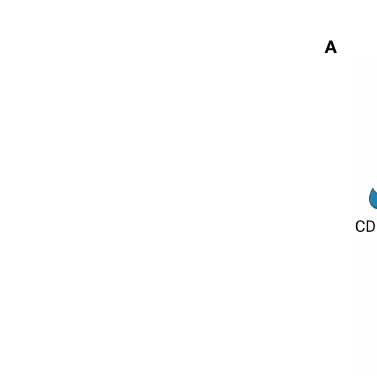
FIGURE 1 | Comparing and contrasting tissue resident memory and effector memory T cell phenotypes in skin. (A) Tissue resident memory (TRM, left, blue) cells downregulate S1P1 and CCR7, which are used for recirculation in the blood and lymph, when they take up residency in skin. TRMs use CD69, which was previously thought to be a marker of recently activated T cells, to block the expression of S1P1 on the cell surface and prevent exit from the tissue. CD103 is an integrin family member that is involved in skin and mucosal homing. It is not required for skin retention, but is expressed at a much higher rate in TRM cells in the epidermis compared to T cells in the dermis. CD49a has recently been used to distinguish the CD8+CD103+CD49a+ TRM T cells involved in mediating disease in vitiligo from the CD8+CD103+CD49a- TRM cells involved in psoriasis. TRM cells survive long-term in the nutrient-poor conditions of the skin by metabolizing free fatty acids. Increased expression of FABP4 and FABP5, fatty-acid binding proteins, allows TRM cells to take up larger amounts of exogenous free fatty acids for energy. IL-15 is required for TRM differentiation in skin, and TRM bear the CD122 and CD132 receptor chains. Keratinocytes can present IL-15 to TRM in trans on the CD215 receptor chain. TRM cells increase expression of PD1, which has a known inhibitory role in immune activation, and is important in maintaining immune homeostasis. Reduced expression of PD-1 in TRMs is associated with inappropriate chronic in fl ammation. CD69, which was historically thought to be a T cell activation marker, is stably expressed on Trm. (B) T effector memory (TEM, right, green) cells can also express varying levels of PD-1, making this marker useful more for determining exhaustion and/or chronic in fl ammation rather than tissue residence. TEM seem to rely more on CD127/IL-7 as a survival factor, which is in contrast to the IL-15 dependency of TRM. More often, they express CD49d than CD49a, though CD49a may also be used as a marker of degranulation. CD49d can interact intracellularly with CD44 to promote signaling, though CD44 is often present on both TRM and TEM and is used as a marker of “ antigen experienced ” T cells. CD45RO has historically been used to identify TEM in blood, and this short isoform of CD45 plays a role in T cell activation and signaling though a variety of pathways including JAK/STAT and Src. The transcription factors BLMP1 and ID2 promote expression of TEM-associated markers. Created with